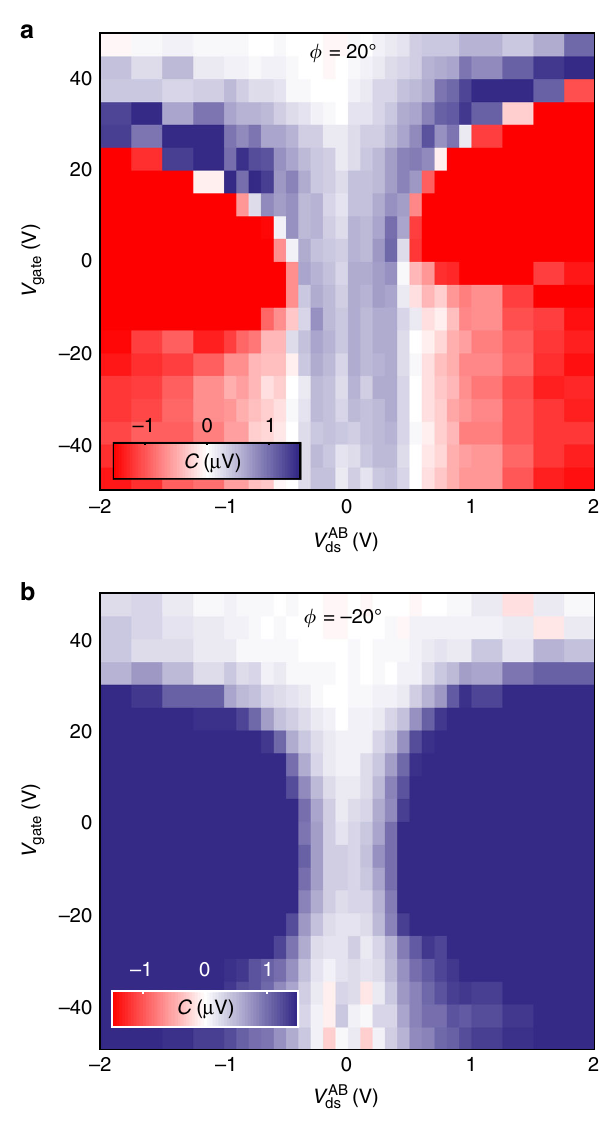
Fig. 5 Effect of the gate voltage in the CPC. a Colormap of the CPC amplitude, C for λ = 785 nm as a function of the drain-source and gate voltages, V ds and V gate for ϕ = 20°. b Same as a for an incidence angle ϕ = −